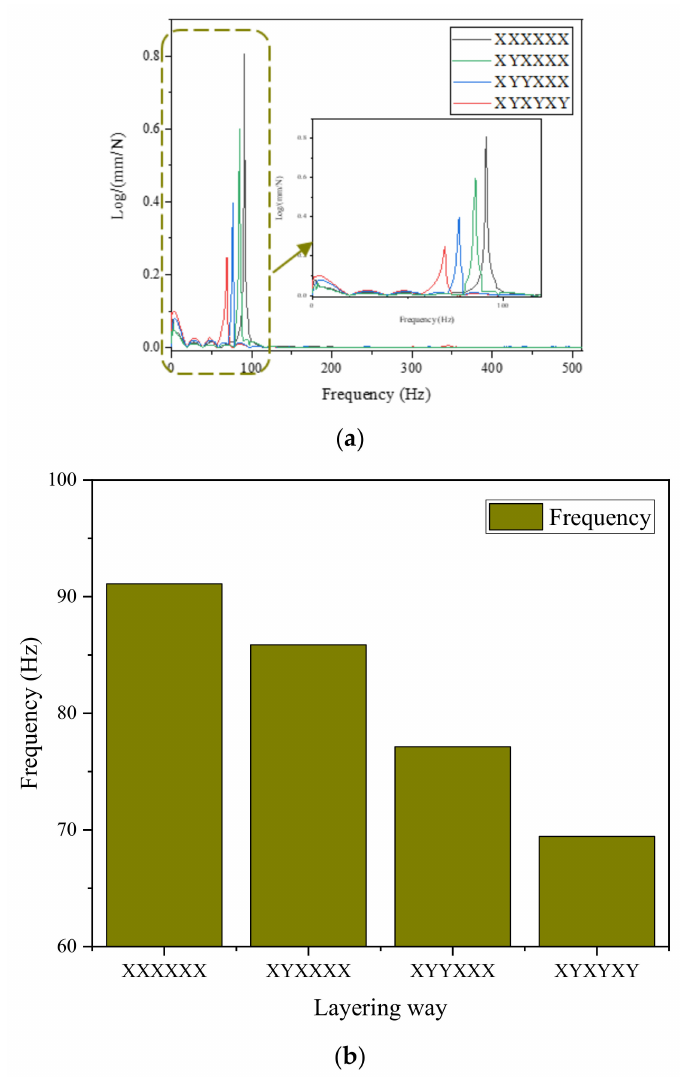
Figure 11. The first-order resonance frequency of different layering ways. ( a ) Frequency–response curve; ( b ) The first-order resonance frequencies of different layering